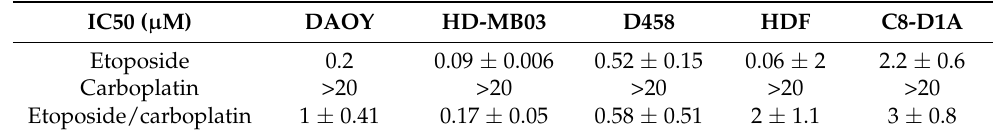
Table 3. Comparison of the toxicity of etoposide, carboplatin and etoposide/carboplatin combination treatments. The IC50 ( µ M) values determined by means of MTT tests after 48 h exposure of three MB cell lines are presented (values are mean IC50 ± standard error of the mean from at least three independent